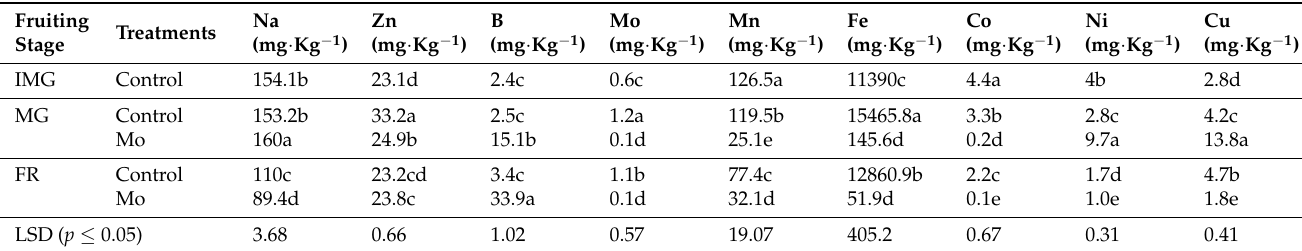
Table 3. Micronutrient concentrations in leaves of loquat as affected by the foliar application of molybdenum. Fruiting Stage